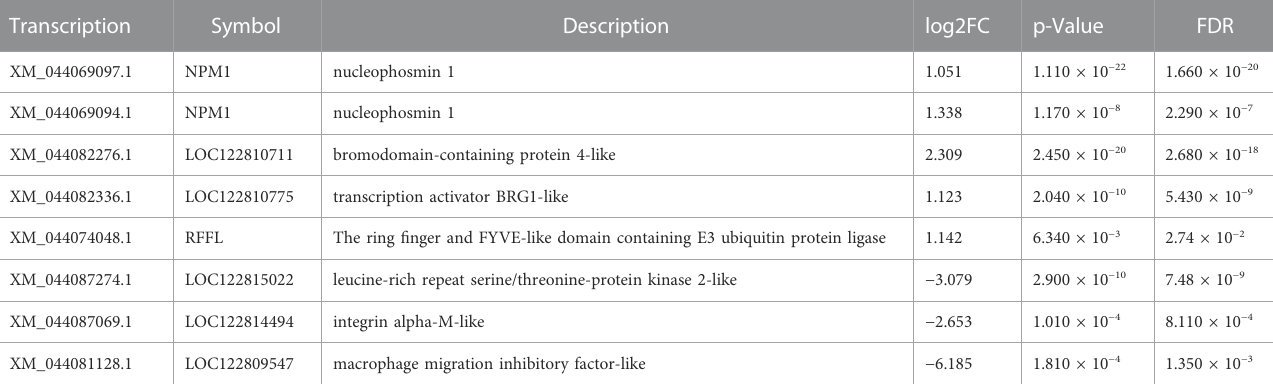
TABLE 1 Select differentially expressed genes in gills.